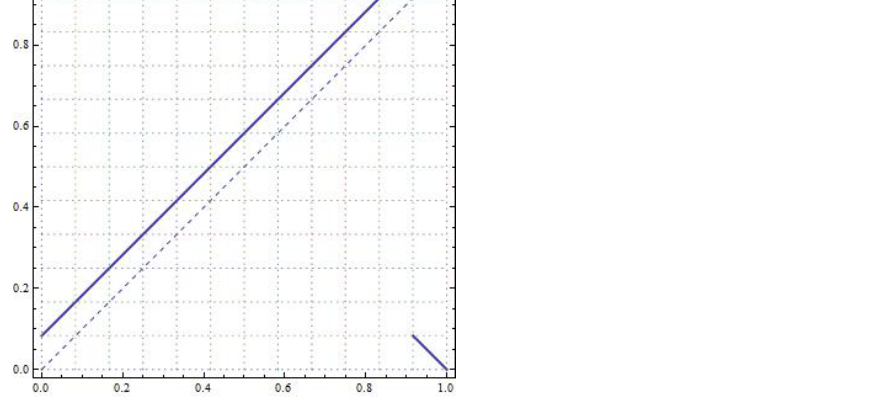
. The displayed grid is made with the endpoints of the intervals I j , 12